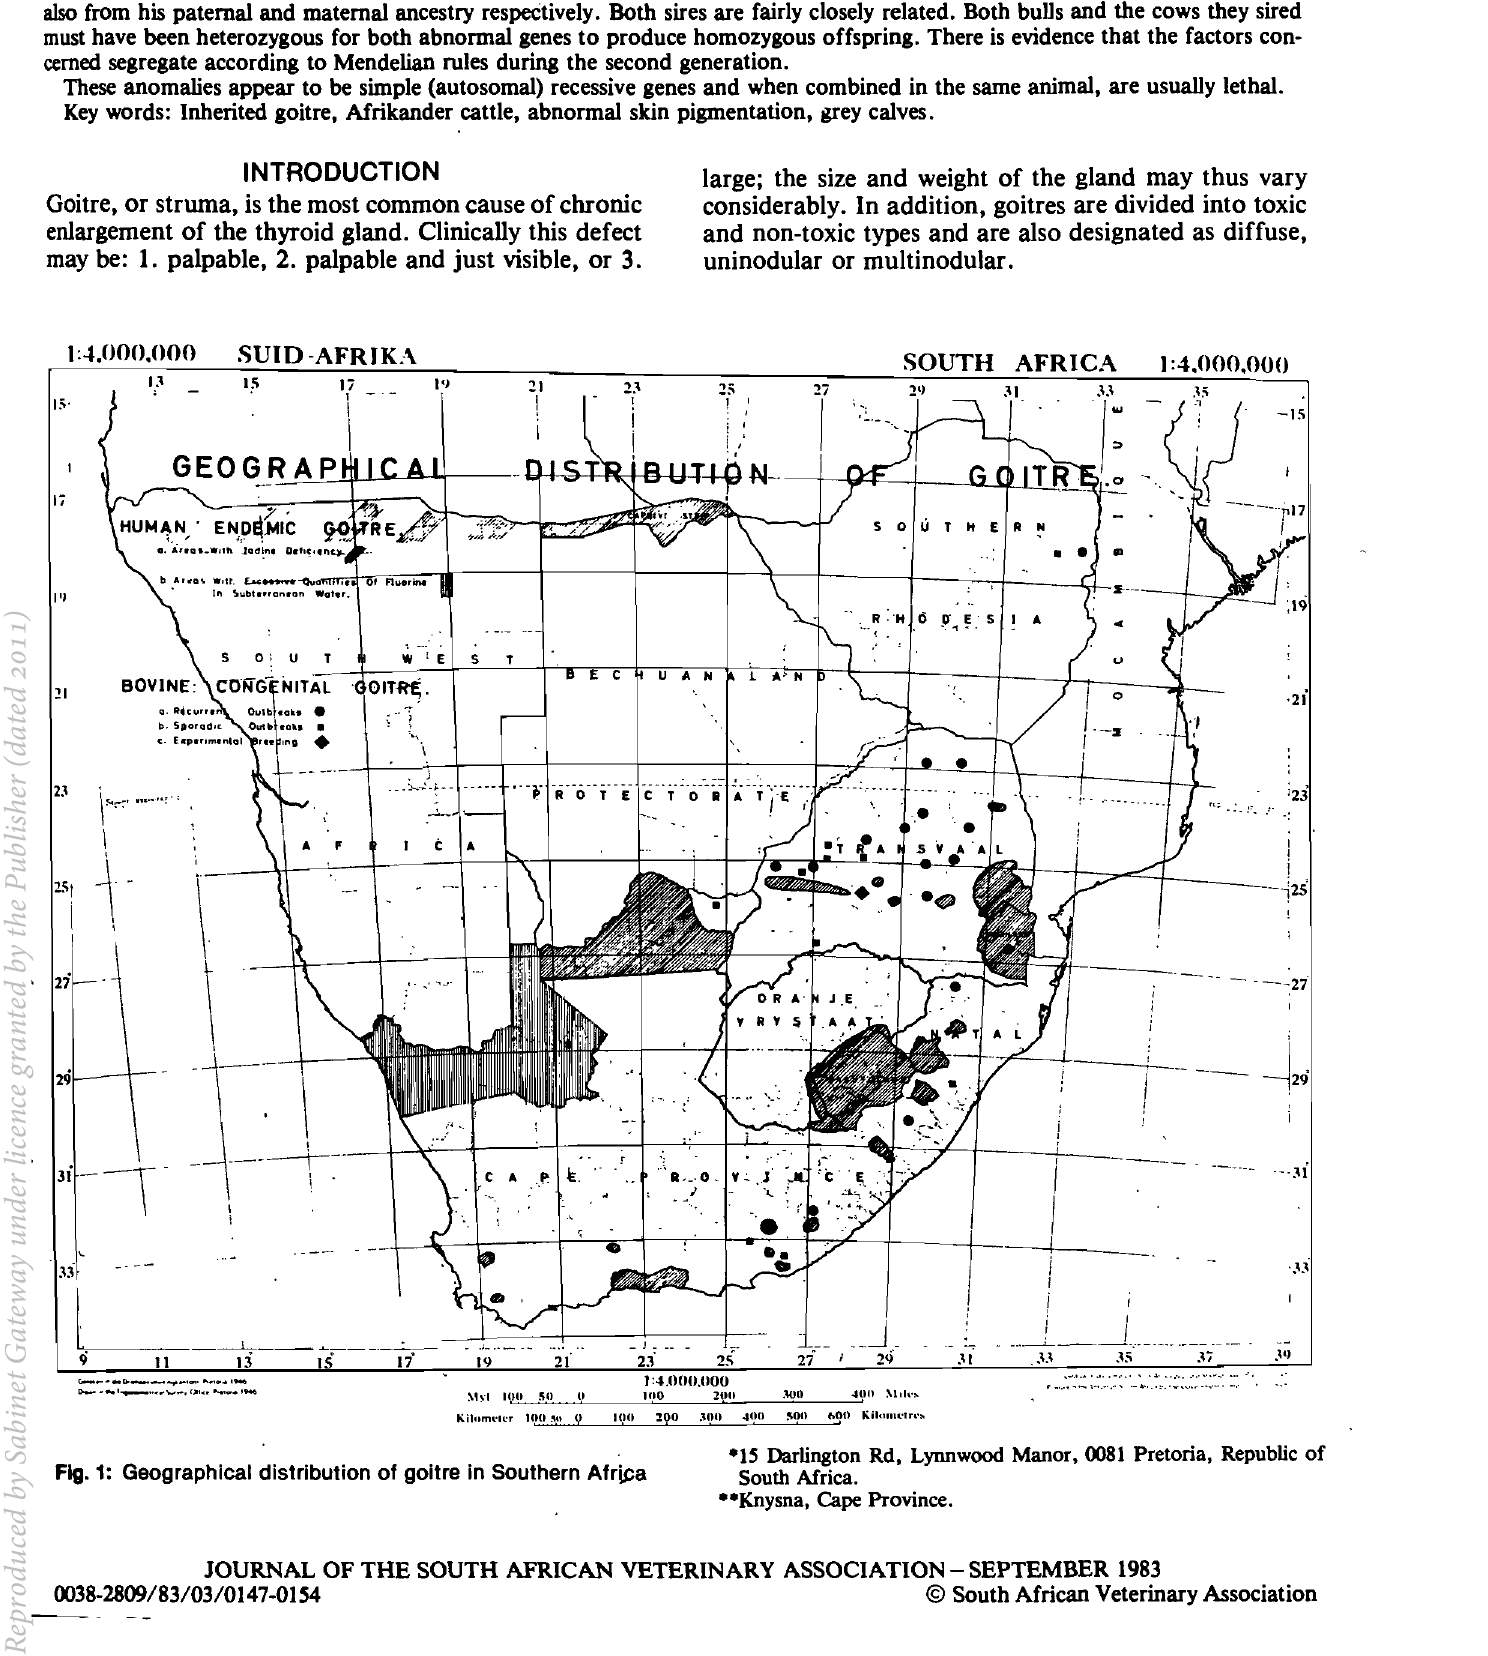
Fig. 1: Geographical distribution of goitre in Southern Afrit;a